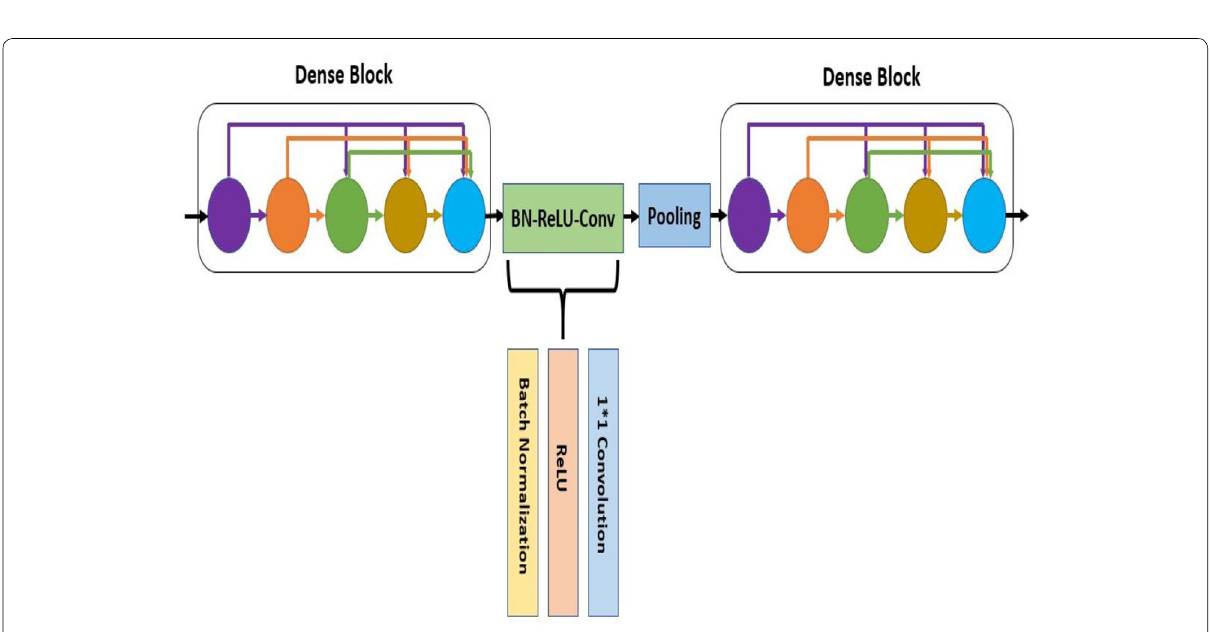
Fig. 4 Illustration of two dense blocks and their intermediate